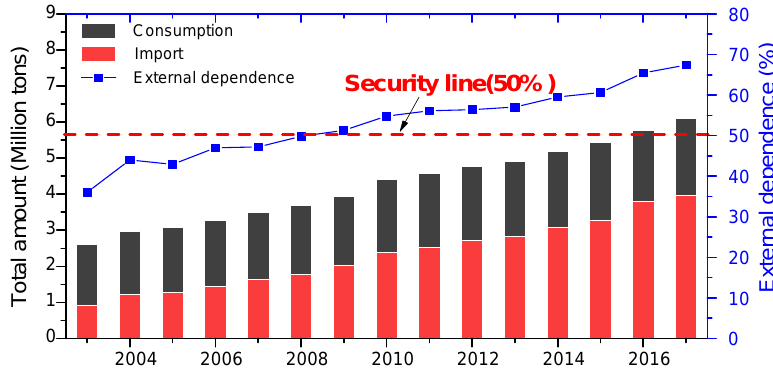
Figure 1. The current reserve and security situation of crude oil in China.